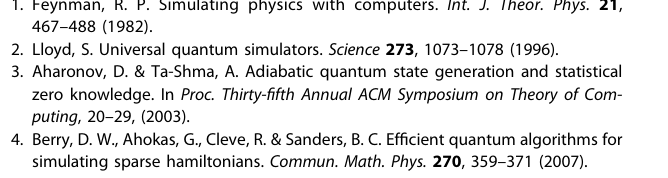
All relevant data used for Fig. 1 are available from the